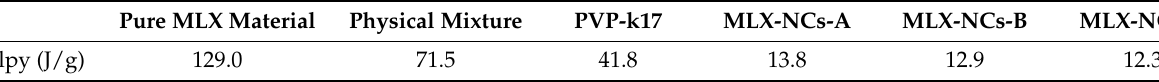
Table 1. The enthalpy values in the DSC transitions.